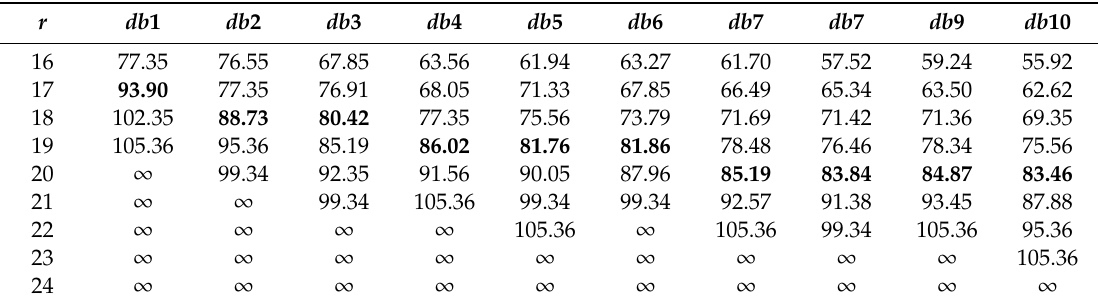
Table 3. Calculation results ( PSNR , dB) of 3D medical images (with 16 BPC) DWT by using bit-width r of Daubechies wavelets filters coe ffi cients.